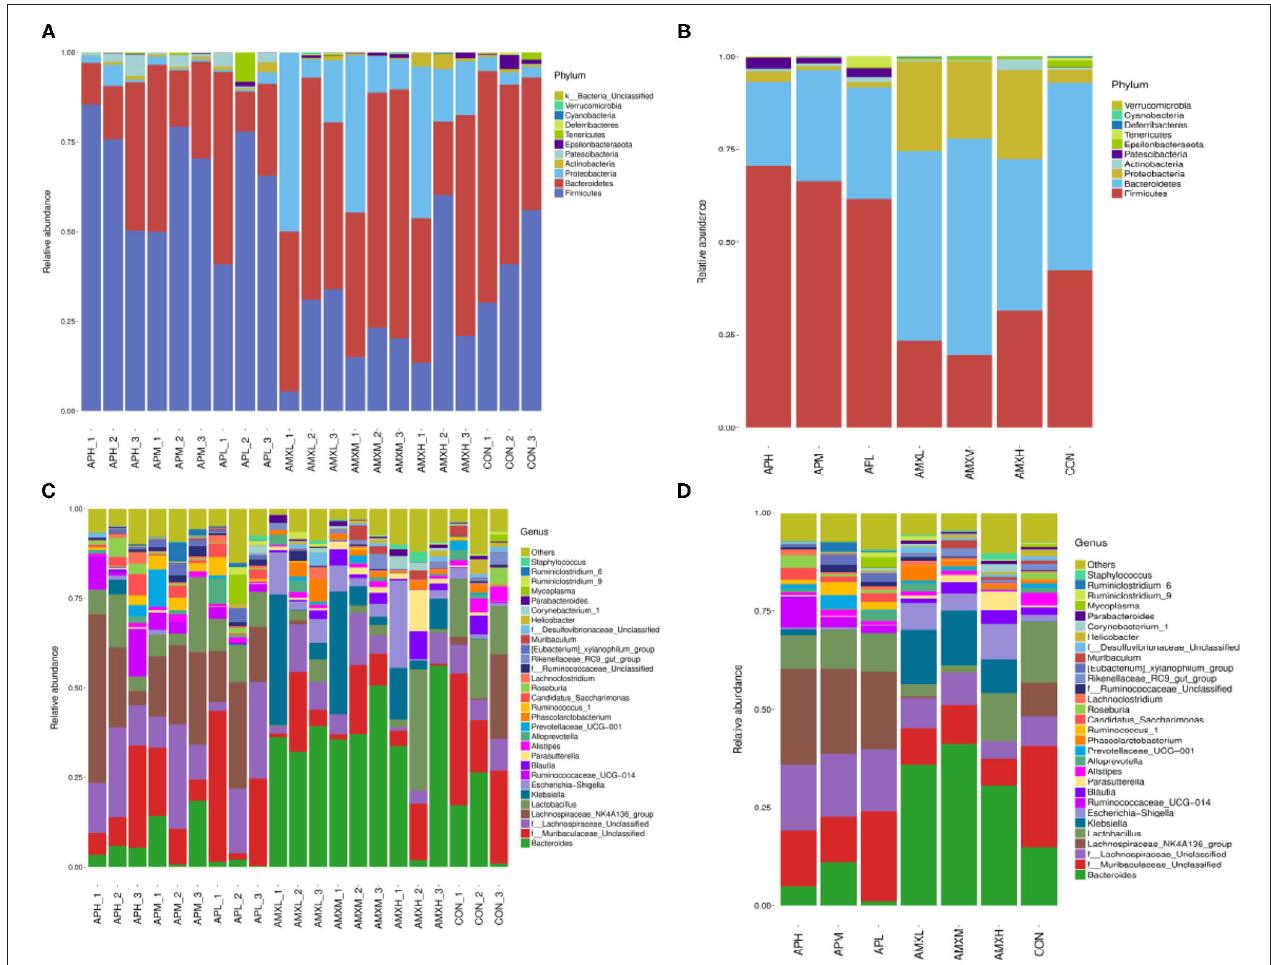
FIGURE 4 | The relative abundance of the gut microbiota at the phylum (A,B) and genus (C,D) levels.